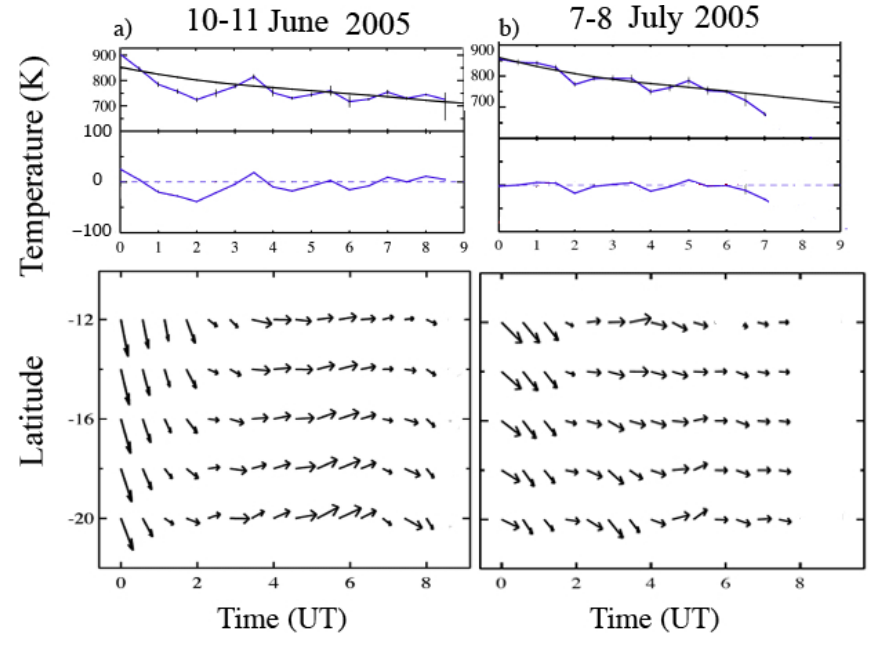
Fig. 10. Results for the nights of (a) 10–11 June 2005, and (b) 7–8 July, 2005. The top row of panels shows the temporal sequence of cycle-averaged temperatures (blue data points and line) compared with the NRL-MSIS00 model (black line). The middle and bottom rows of panels show for both nights the plot of the differences between observed temperatures and MSIS model values and the maps of horizontal winds, respectively. Local midnight is 05:00UT. The horizonal meridional or zonal wind speed of 100ms − 1 is represented by the distance of 2 ◦ latitude or 30min,